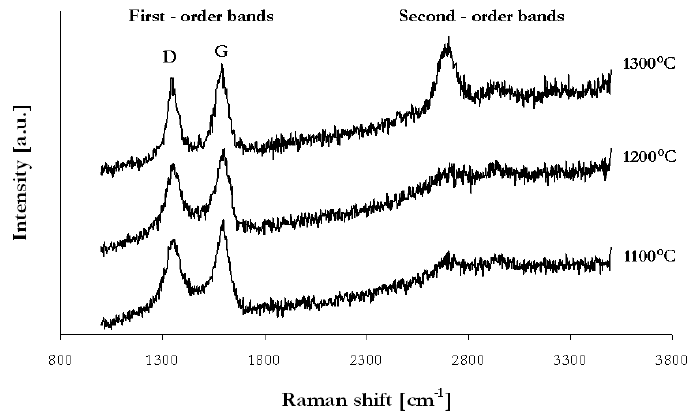
Figure 3: Raman spectra of Py-C deposited at 1100, 1200 and 1300